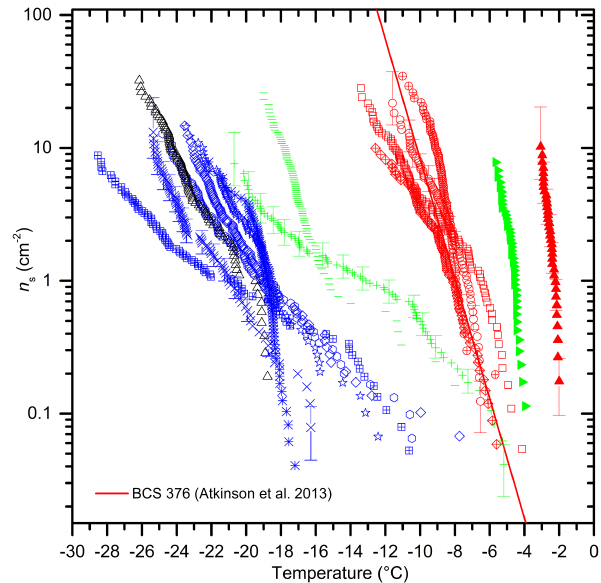
Figure 3. Ice nucleation efficiency expressed as n s ( T ) for the var- ious feldspars tested in this study. The symbols are the same as those used for Fig. 2. The K-feldspars are coloured red, the pla- gioclase feldspars are coloured blue, the albites are coloured green and the feldspar glass is coloured black. Except for Amelia albite and TUD#1 microcline all samples were tested twice and the data from the two runs combined. Sample information can be found in Tables 1 and 2. Temperature uncertainty is ± 0.4 ◦ C. Y-Error bars calculated using the Poisson Monte Carlo procedure described in Sect. 4. Data points with large uncertainties greater than an order of magnitude have been removed, these are invariably the first one or two freezing events of a given experiment. For clarity error bars have only been included on a selection of data sets (TUD#3 mi- crocline, LD1 microcline, BCS 375 albite and 67796b plagioclase). The error bars shown are